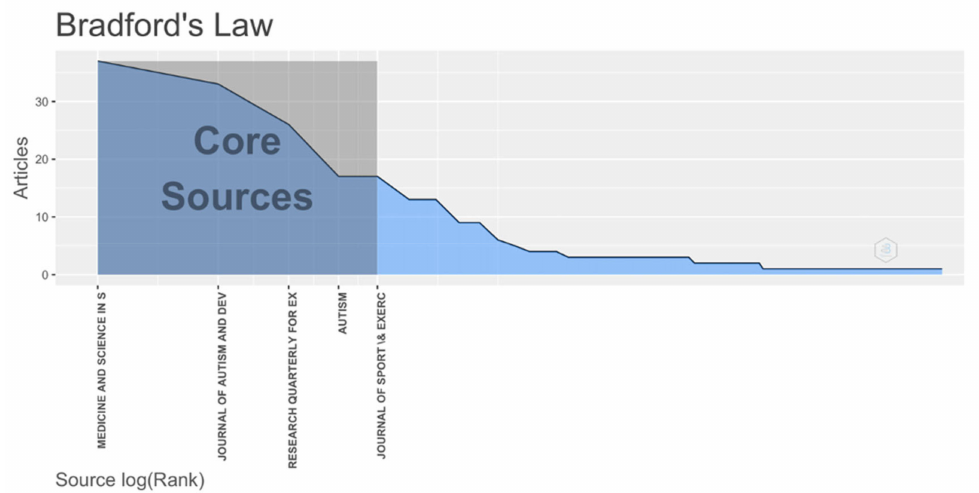
Figure 4. The most prominent core journals in the PA research of ASD based on Bradford’s